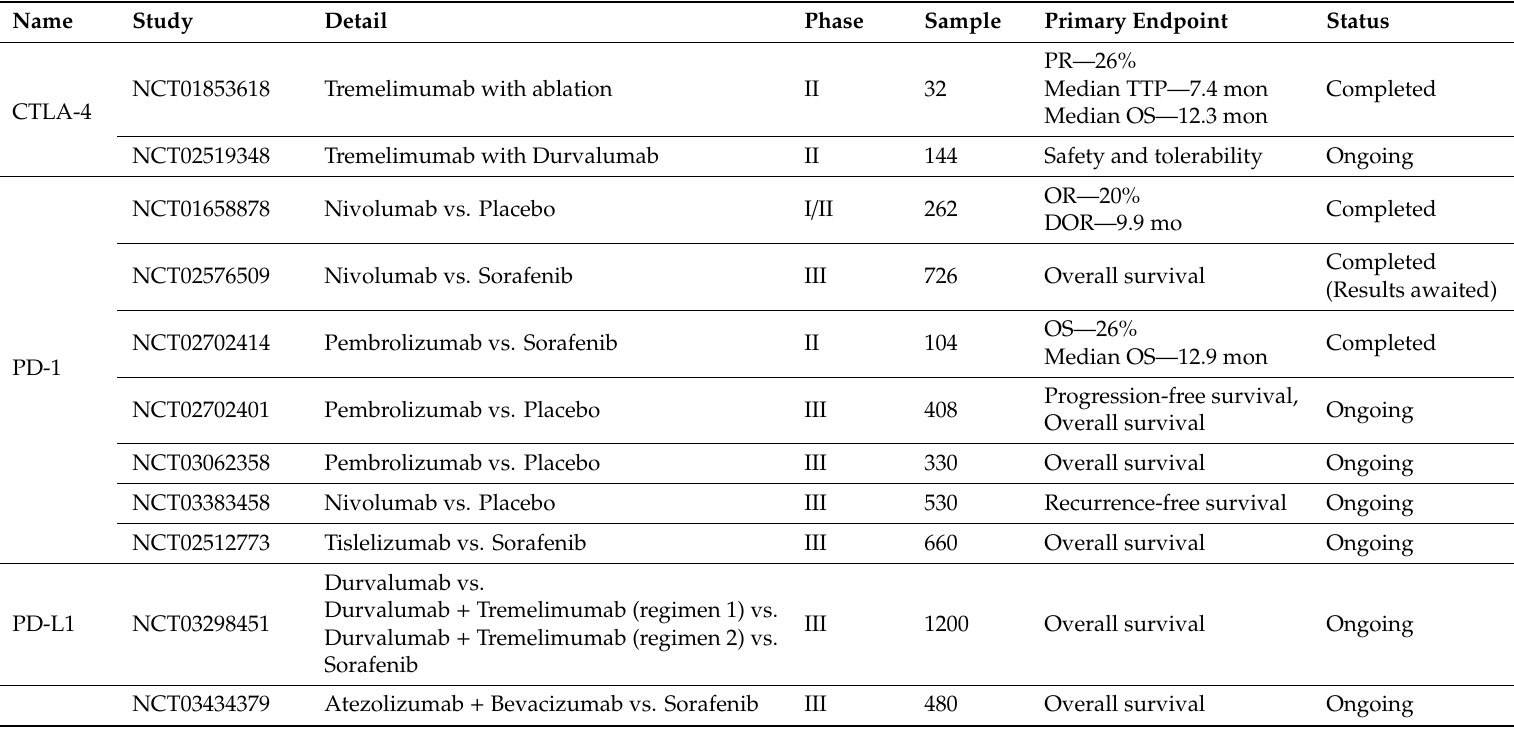
Table 1. Clinical Trials involving various immune checkpoint inhibitors in hepatocellular